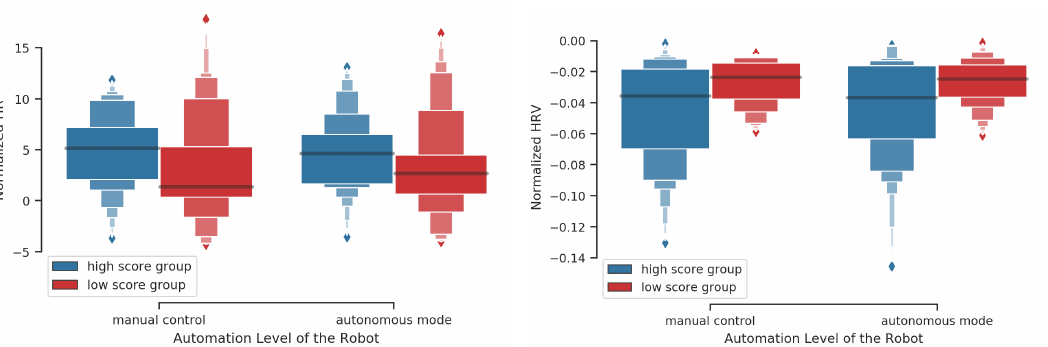
Figure 9. ECG features during autonomous mode and manual control given participants’ performance group.